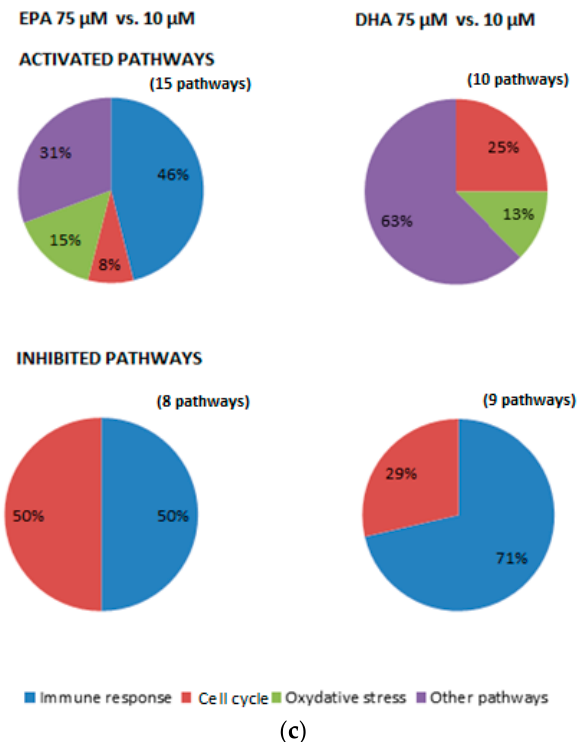
Figure 2 . Effect of EPA and DHA dose reduction (75 µM versus 50 µM, 50 µM versus 10 µM and 75 Figure 2. Effect of EPA and DHA dose reduction (75 µ M versus 50 µ M, 50 µ M versus 10 µ M µM versus 10 µM) on the proportion of modulated pathways belonging to different families ( immune